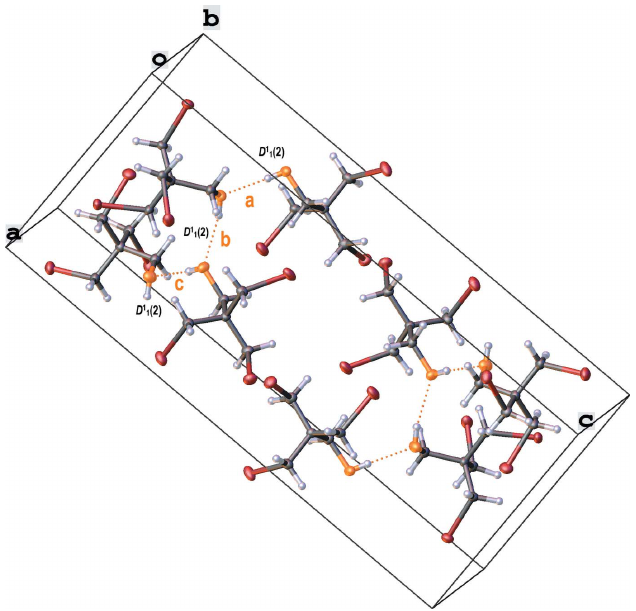
Figure 3 Crystal packing of bromomethylalcohol 1 Hydrogen bonds are shown as dashed lines. Hydrogen bonds a, b and c have the graph-set motif D 1 1